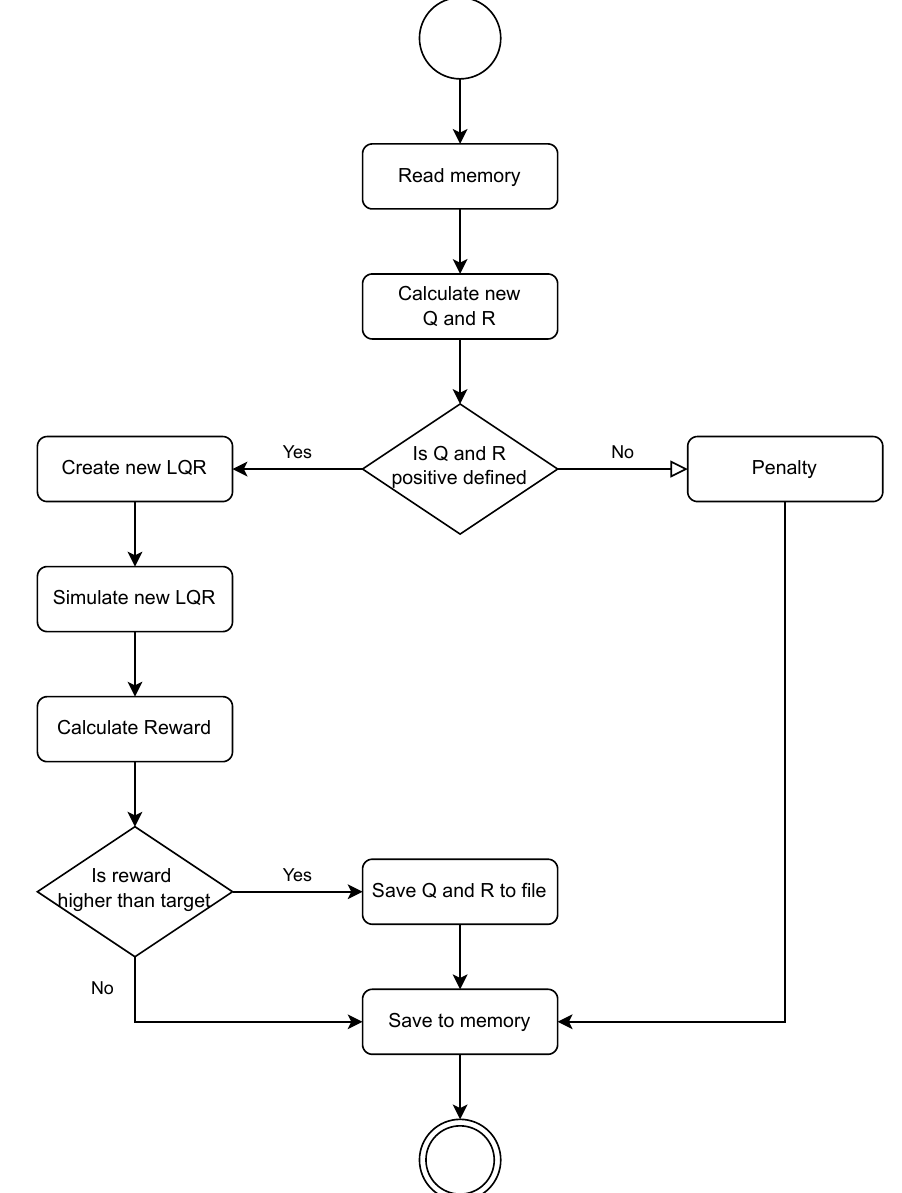
Figure 4. Diagram of a single learning